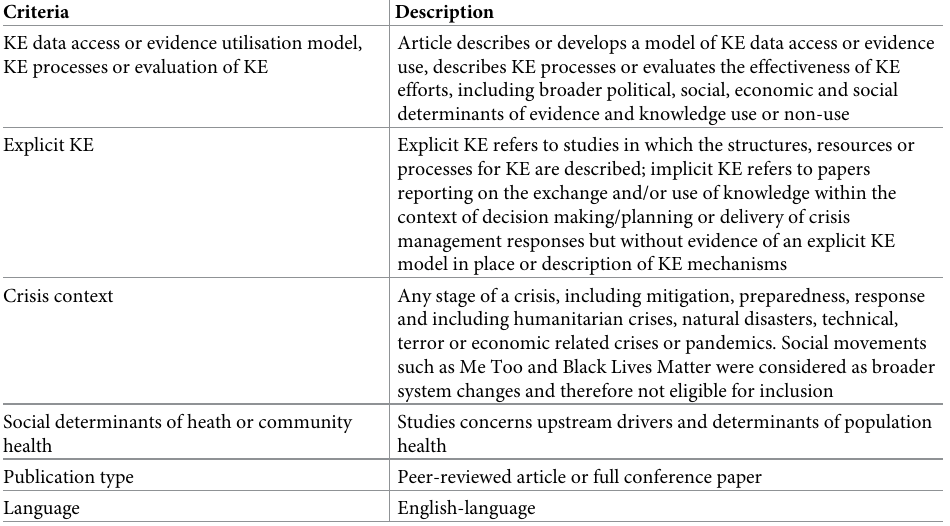
Table 2. Inclusion